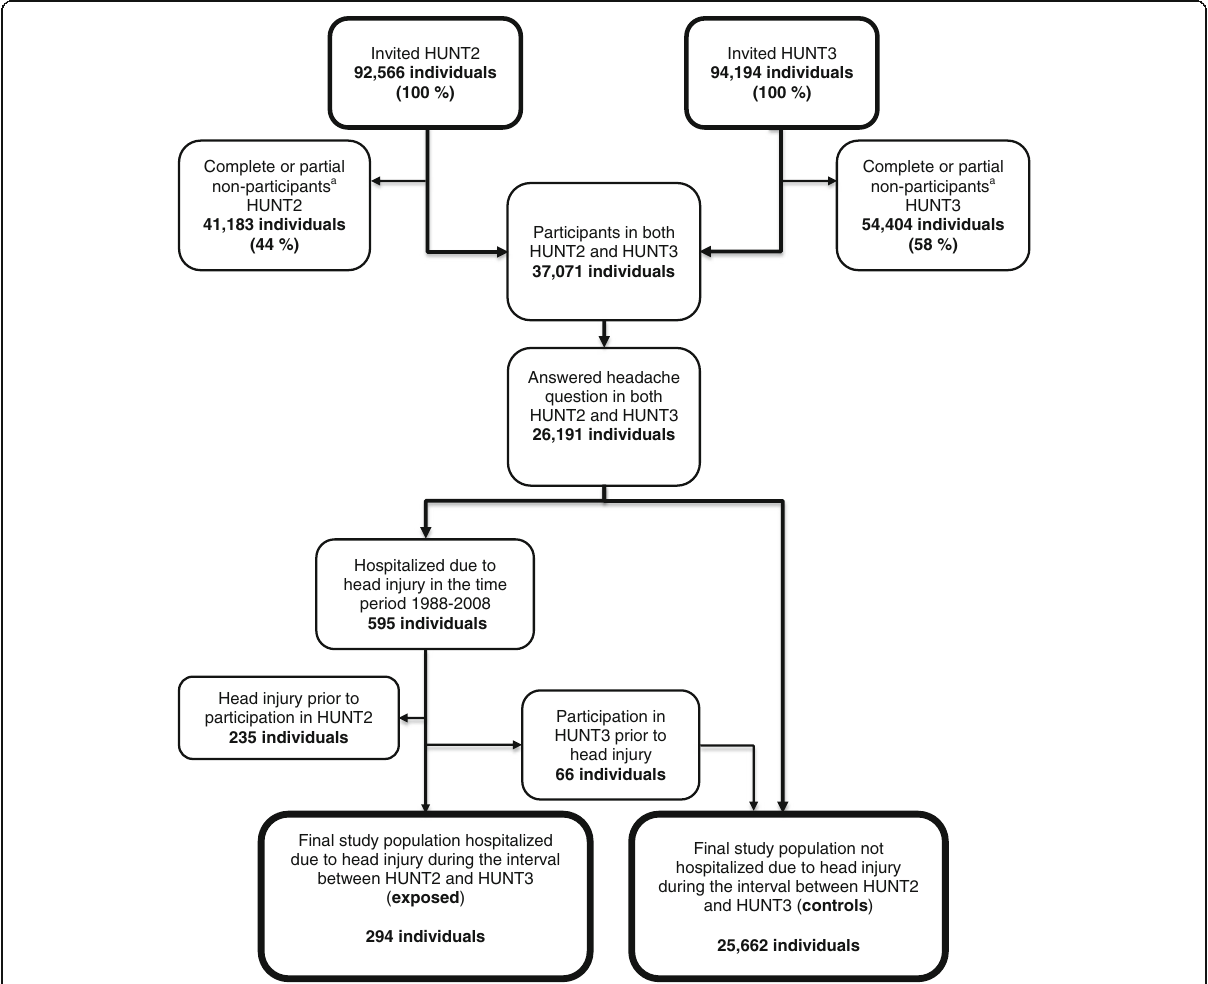
Fig. 1 Flow of participants through the HUNT2 and HUNT3 study and selection of head injury patients. a Complete non-participants: Answering no questionnaire. Partial non-participants: Answering part of the questinonnaire, but not the headache screening question. Abbreviations: HUNT=the Nord-Trøndelag Health